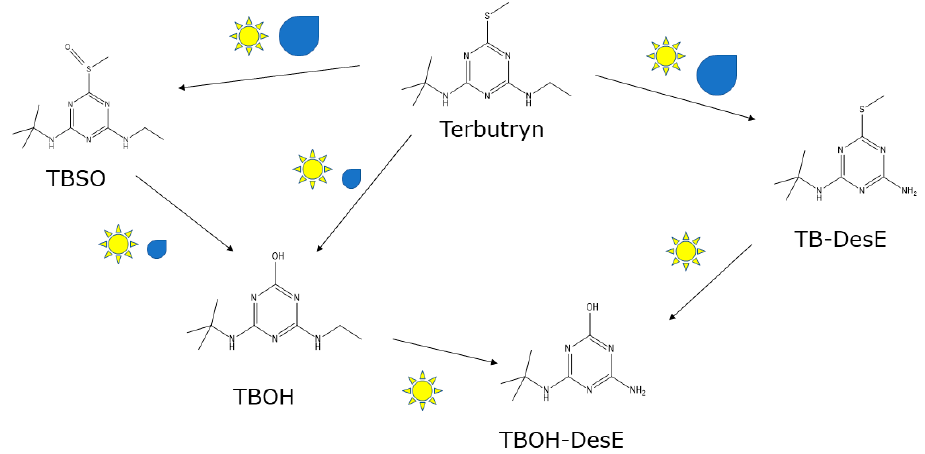
Figure 2. Transformation of terbutryn under natural weather conditions. The scheme includes only transformation products that were detected in this study. It indicates whether an increase of transformation products was observed after relatively large amounts of driving rain (symbol: water droplet) or global radiation (symbol: sun).